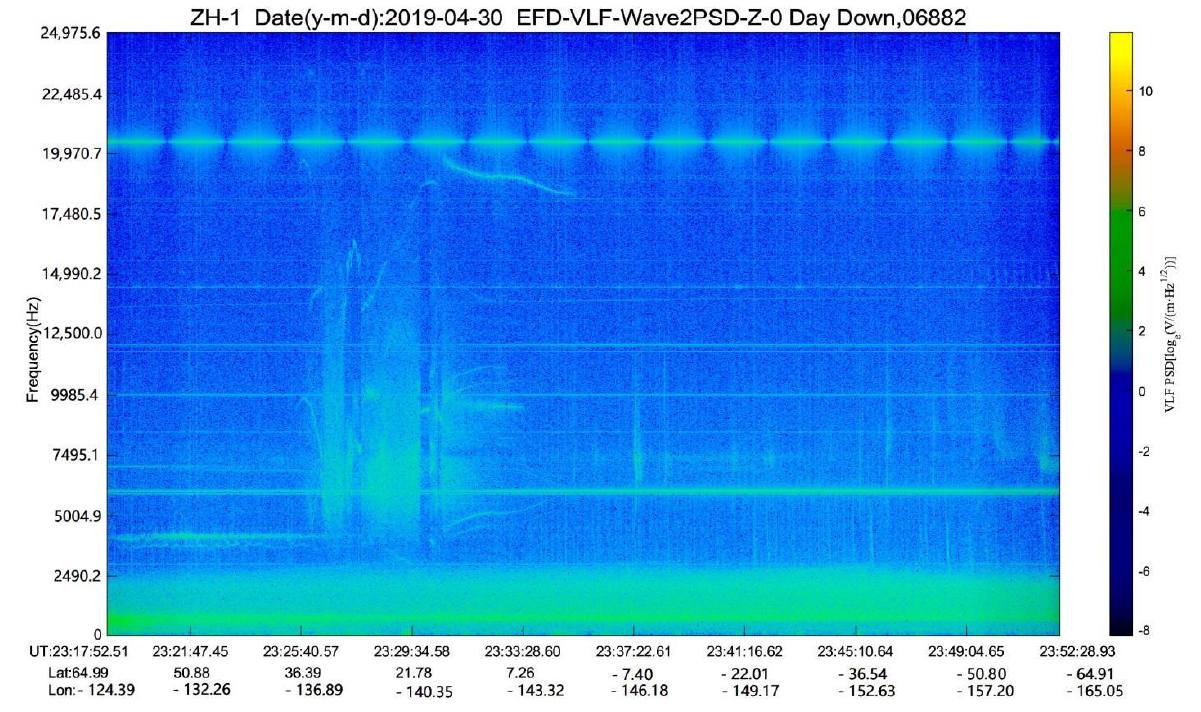
Figure 3. The VLF from 23:17 to 23:52 on 30 April 2019 spectrogram of ZH-1 EFD.